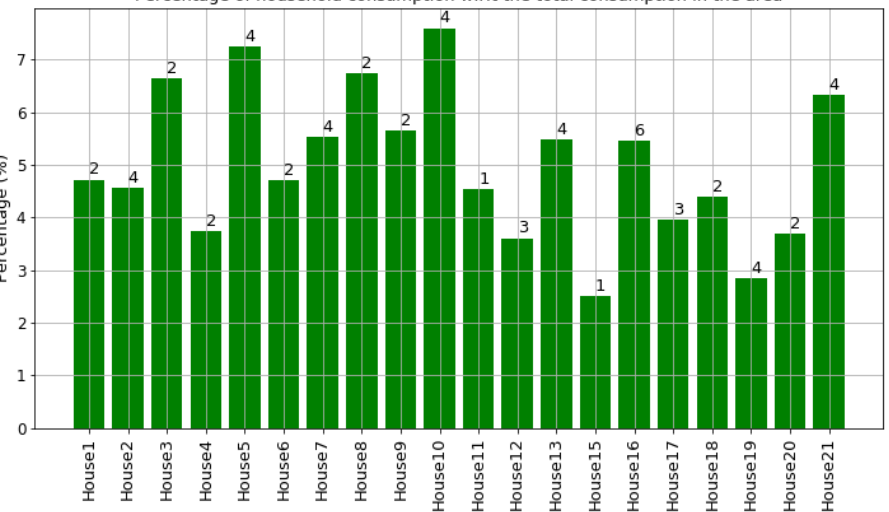
Figure 8. The percentage of household consumption w.r.t the total consumption in the area for each household. The numbers at the top of bars are the household